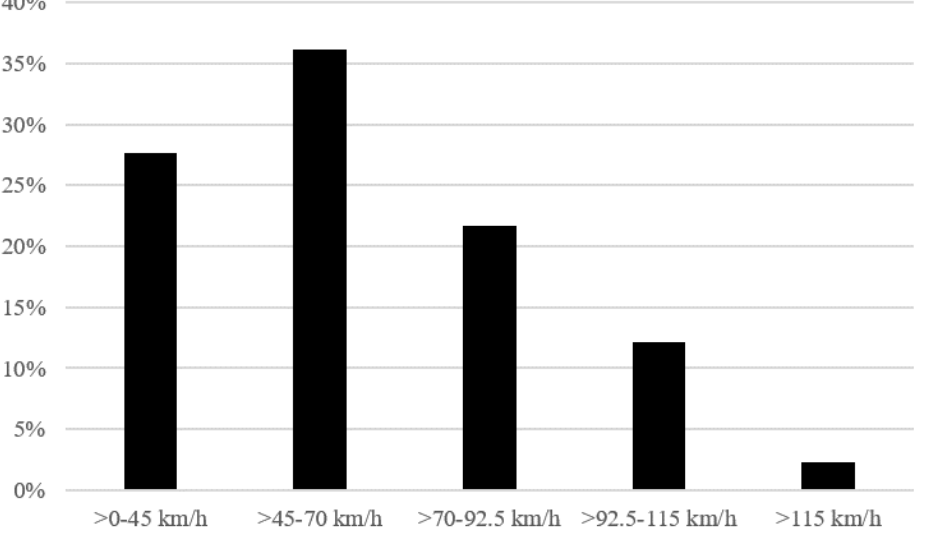
Figure 8. Percentage share of different velocities for an example